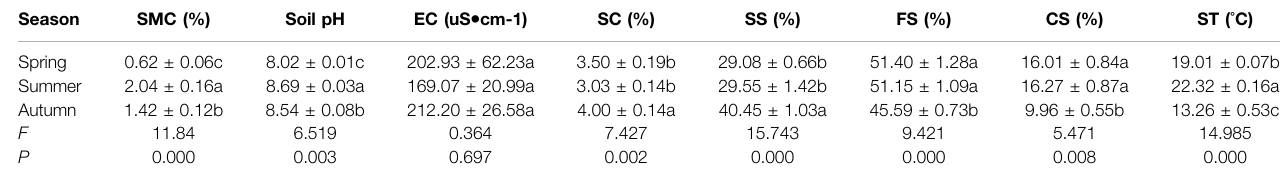
TABLE 1 | Values of the environmental factors in three seasons in the Urad desert steppe. Values are means ± se. Different letters within a column represent signi fi cant differences at p < 0.05. SMC = soil moisture content, EC = electrical conductivity, SC = soil clay, SS = soil silt, FS = fi ne sand, CS = coarse sand, ST = soil temperature.